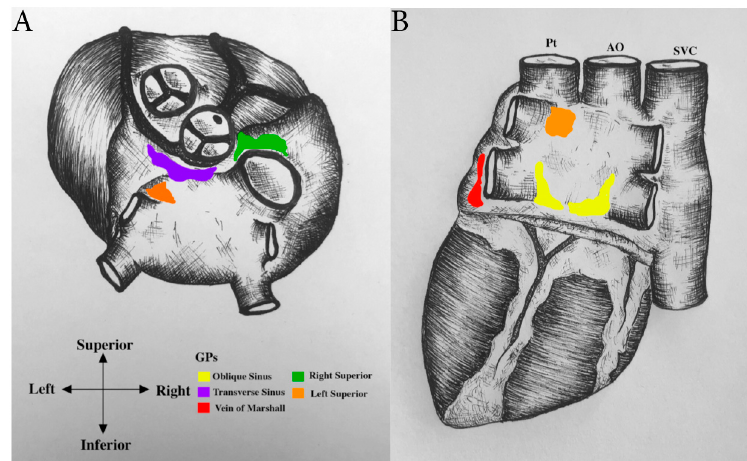
Figure 4. GP’s targeted for ablation. A posterior view of the heart showing all the main ganglionated plexi sites essential for ablation. ( A ) These include the transverse sinus (in purple) and superior right (in green) located between aorta (AO) and superior vena cava (SVC). ( B ) The oblique sinus GPs (in yellow) are situated supero-anterior to the right superior pulmonary vein (PV) (ARPV) and infero-posterior region of the right inferior PV (IRPV). The left superior (in orange) can be found medial to the left superior PV (SLPV). Vein of Marshall (in red) is another target ablation region within the ligament of Marshall. Pt, pulmonary trunk.